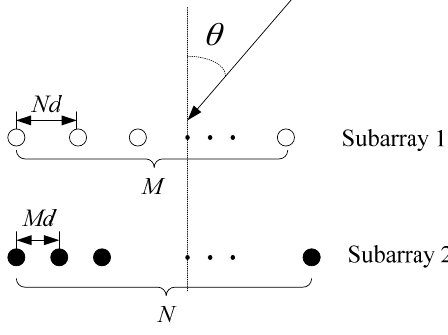
Figure 1. The structure of coprime arrays.